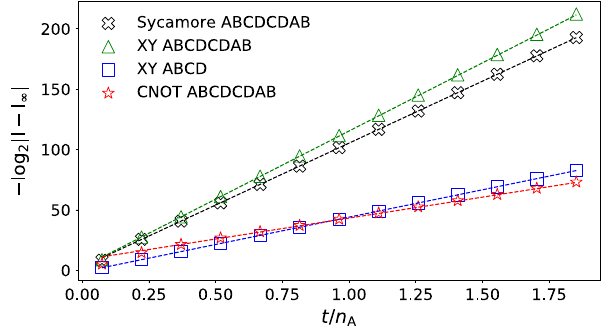
FIG. 18. Purity results for Google-like protocol (symbols, n ¼ 27 ) and the asymptotic linear growth given by the leading eigenvalue − log 2 j λ 2 j (dashed lines). The protocols examined suggest that the purity decay rate agrees with the value predicted from spectral